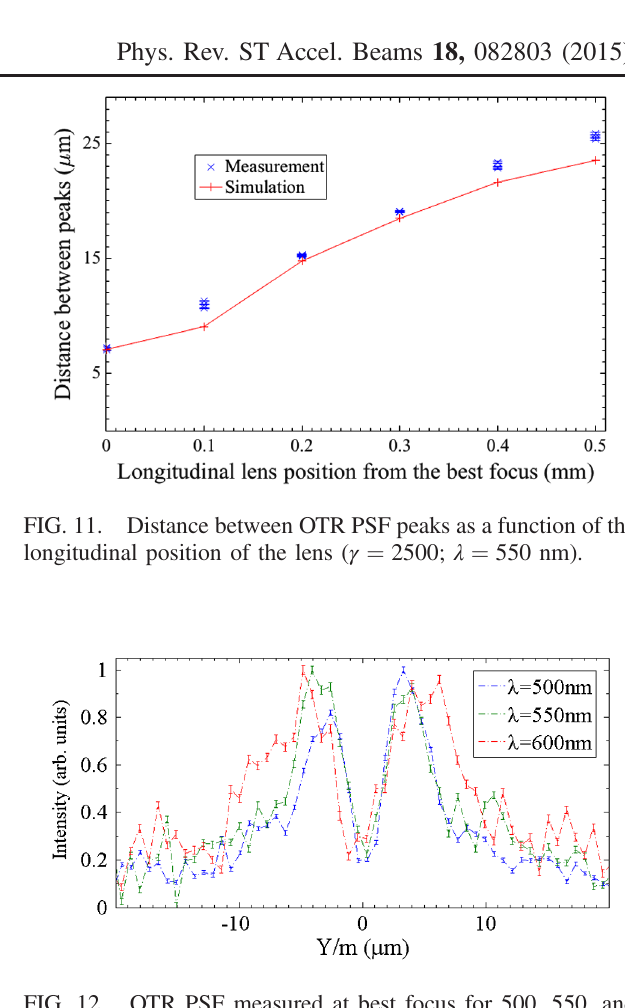
FIG. 12. OTR PSF measured at best focus for 500, 550, and 600 nm wavelength optical filters.